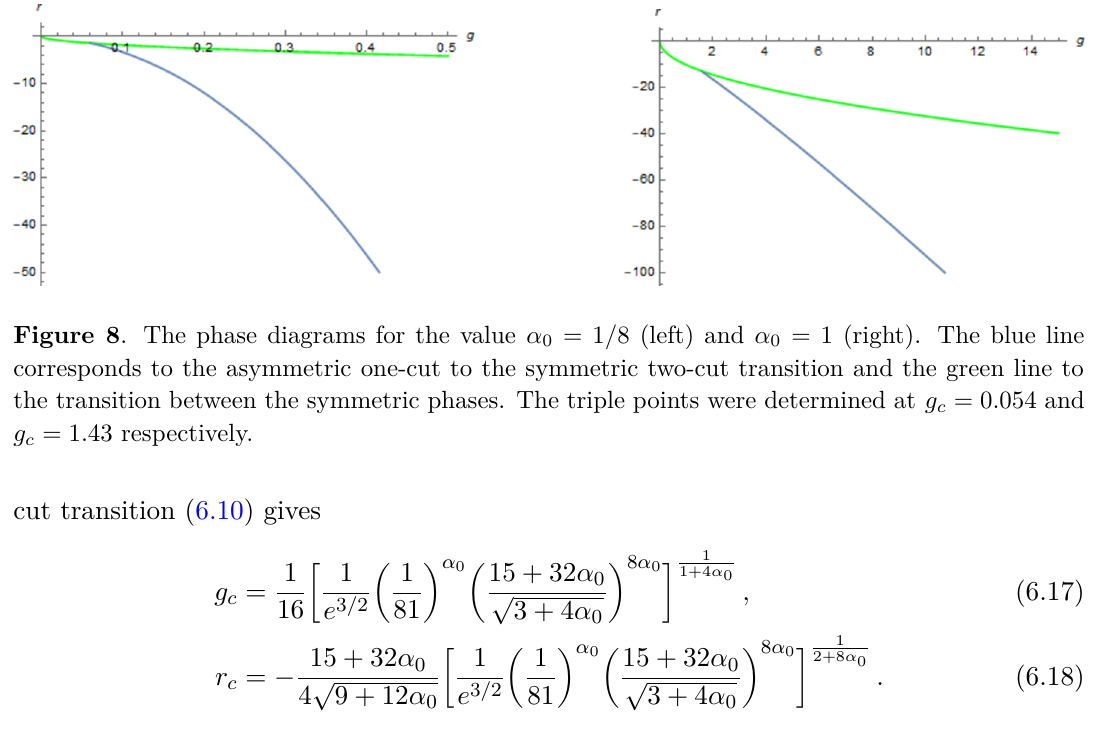
Figure 7 . The phase diagram in case of α 0 = 1 / 48 . The blue line corresponds to the asymmetric one-cut to the symmetric two-cut transition, the red line to the asymmetric one-cut to the symmetric one-cut transition and the green line to the phase transition between the symmetric phases. The asymmetric one-cut to the symmetric two-cut phase transition on the left image is plotted in the dashed style as this transition is less accurate near the origin of the parameter phase due to the order of the Padé approximation. The triple point was obtained at g c = 0 . 0096 .